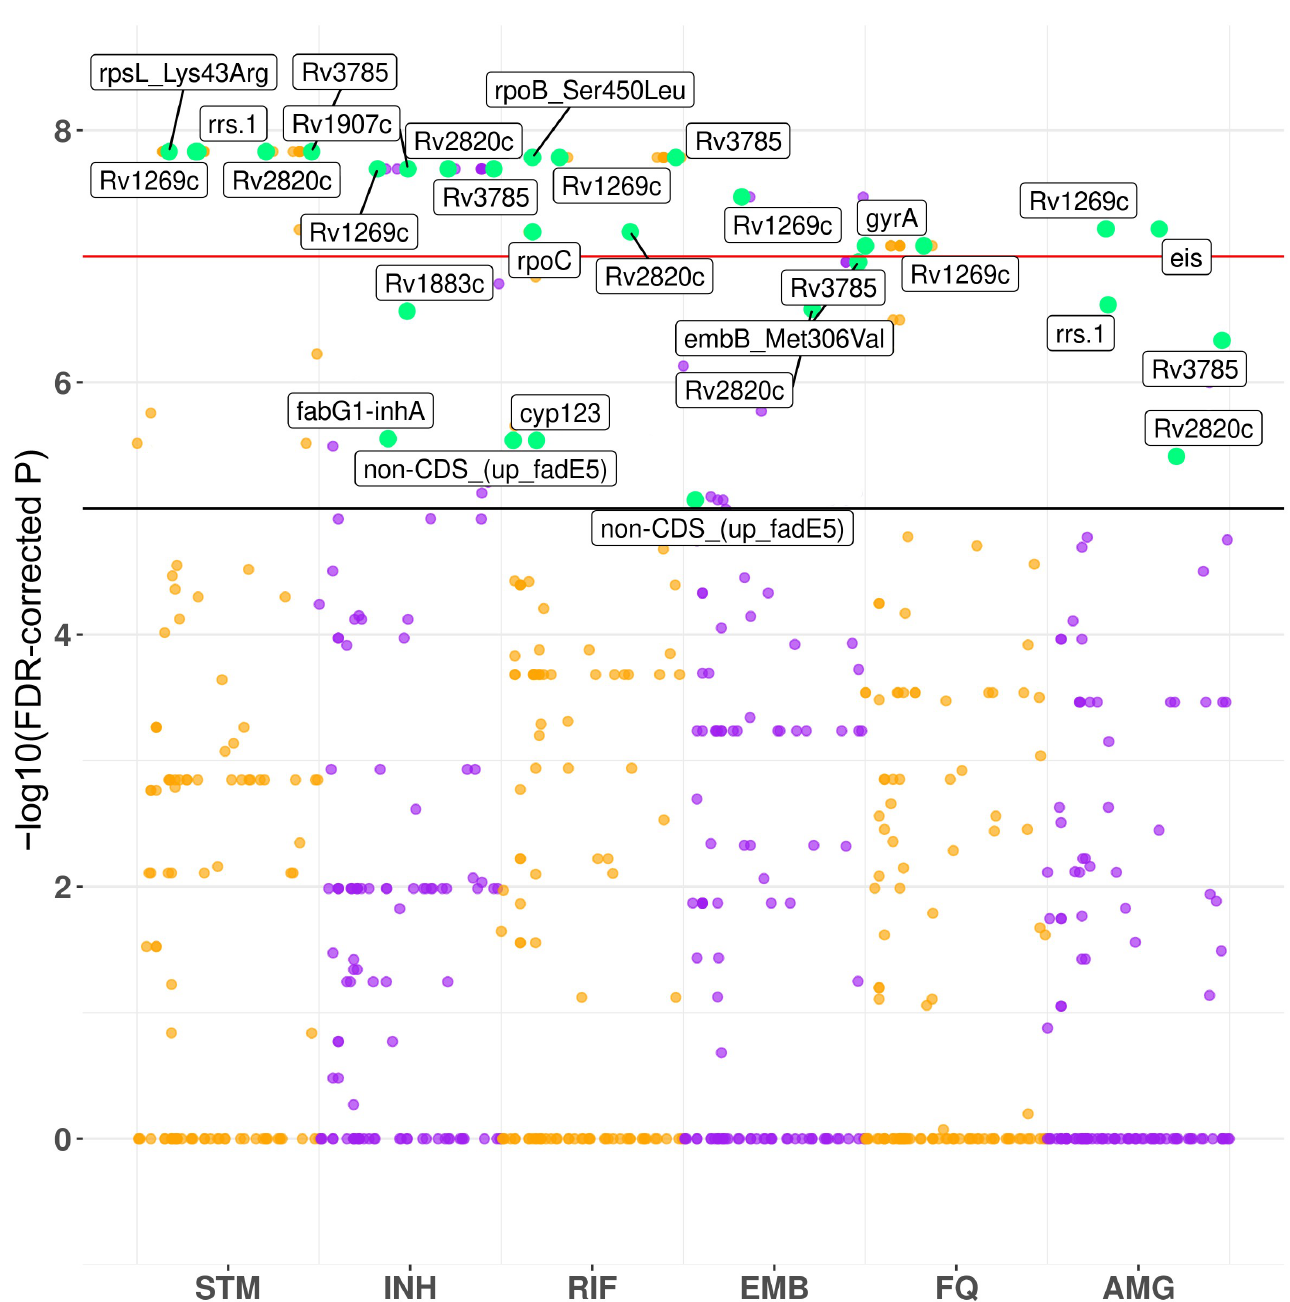
Figure 2. Manhattan plot with PhyC-based GWAS hits for each genotype tested. Green dots show statistically significant hits within and close to coding sequences. Confidence thresholds correspond to p = 1 × 10 −5 and p = 1 × 10 −8